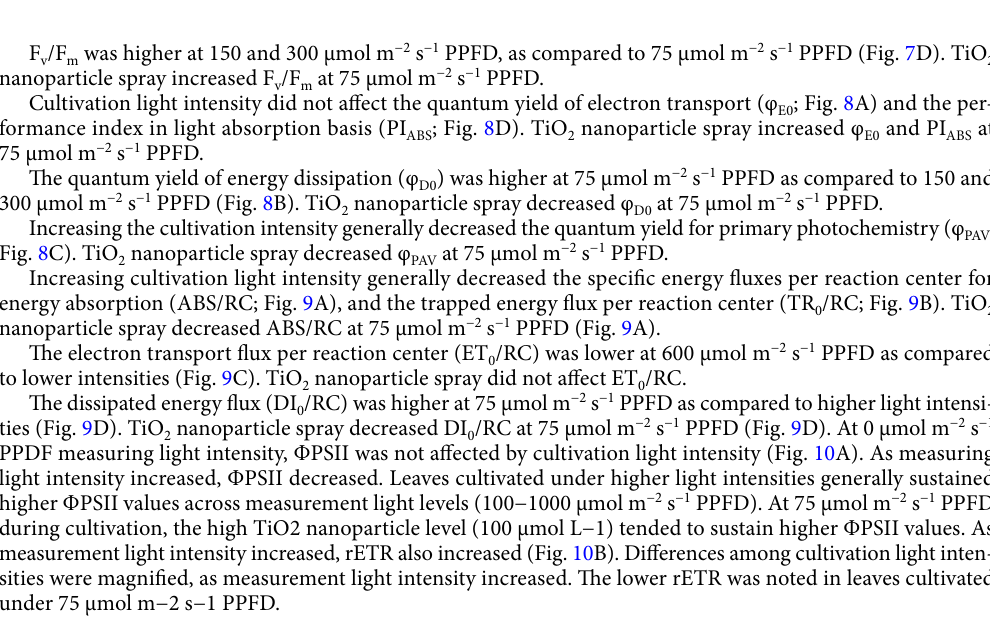
Figure 5. Effect of cultivation light intensity (75, 150, 300 and 600 µmol m −2 s −1 ) and spray treatment (once a week, and three times in total) with titanium dioxide (TiO 2 ) nanoparticles (open, grey, and dark grey for 0, 50 and 100 µmol L −1 , respectively) on total carbohydrates content in leaves and tuber ( A , B , respectively) of radish cv. Cherry belle plants. Six replicate plants were assessed per treatment. Bars represent SEM. In traits, where the interaction of the two factors (light intensity, TiO 2 nanoparticle level) was significant, different letters indicate significant differences. The difference in the y-axis scale among panels ought to be noted. FW, fresh